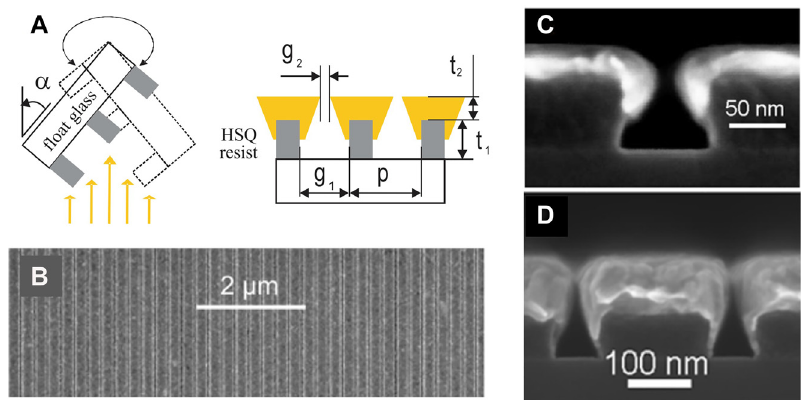
Figure 10: Nanogap fabrication with shadow evaporation